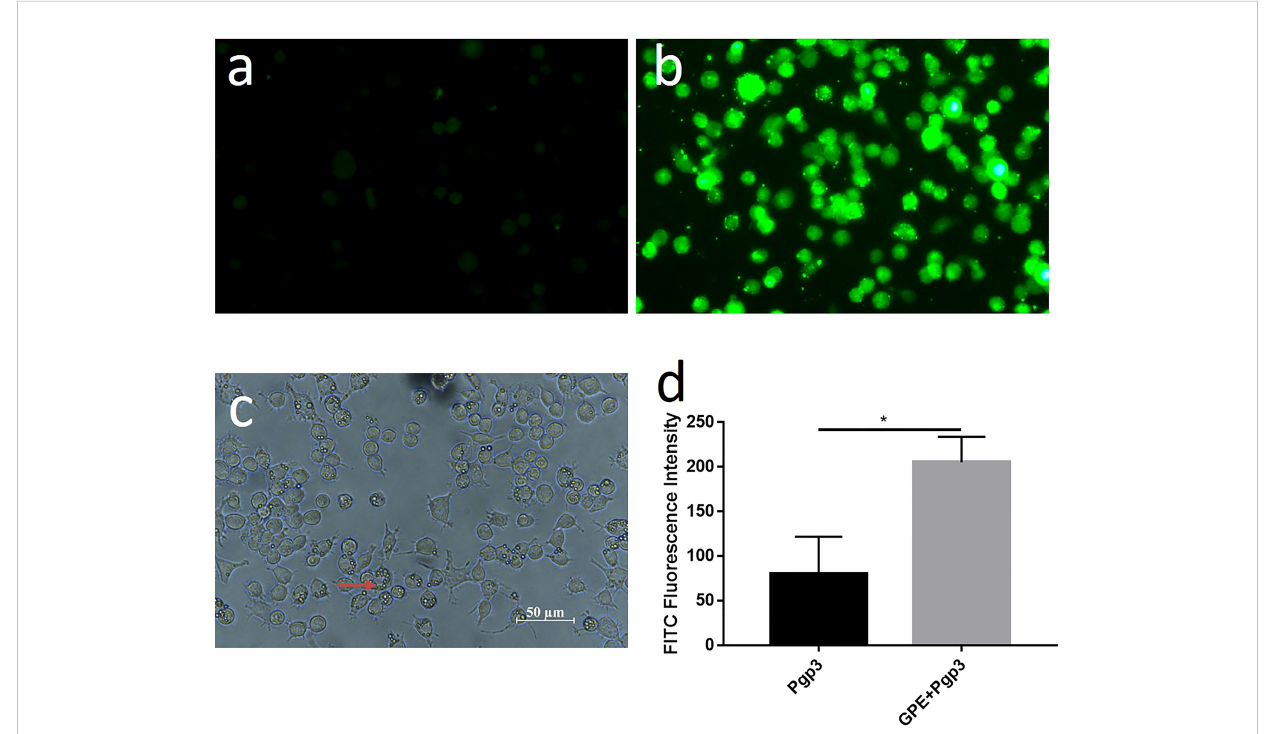
FIGURE 5 Cellular uptake of GPE and Pgp3 (micro image of Pgp3 uptake post incubation 4 h with Raw 264.7 cells. (A) Pgp3; (B) GPE+ Pgp3 in dark fi eld; (C) GPE+Pgp3 in bright fi eld; (D) statistical analysis of FITC fl uorescence intensity 4 h post uptake ( n = 3). FITC, Fluorescein